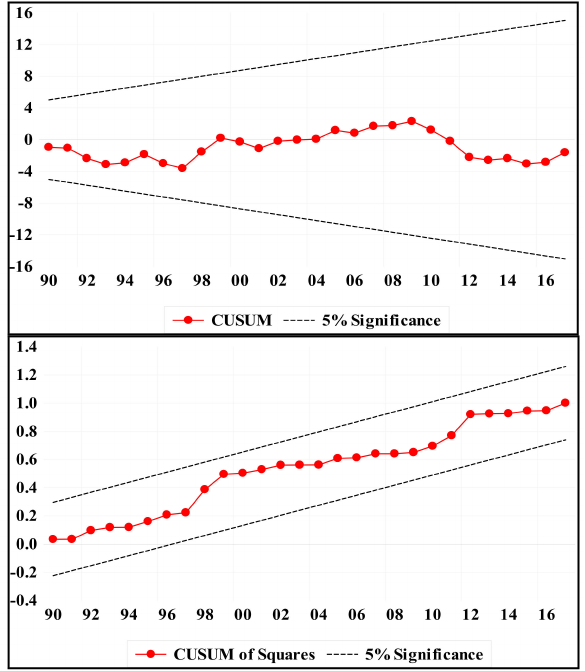
Figure 2. Graphical representation of CUSUM and its